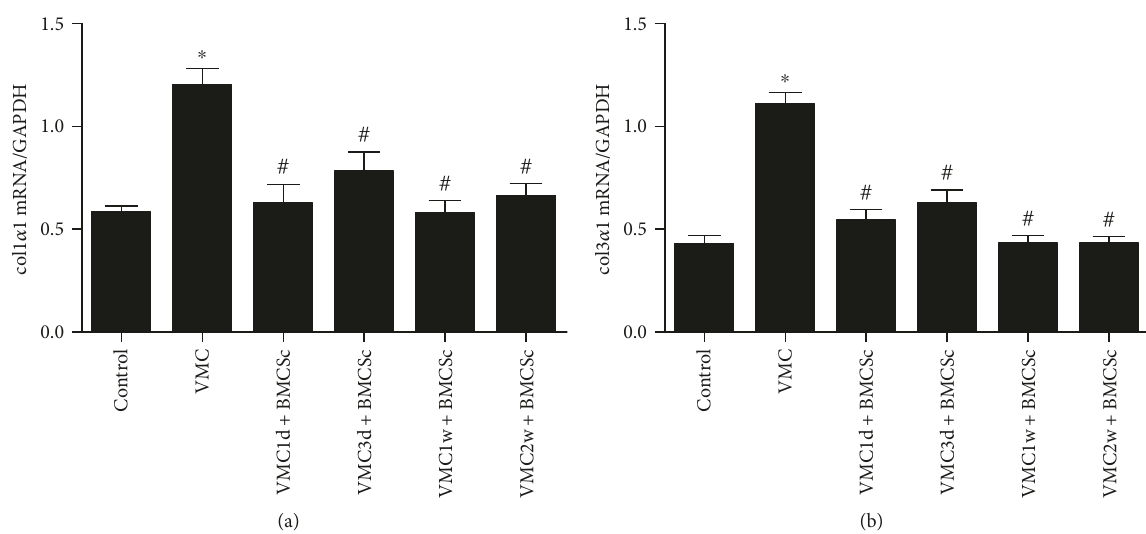
Figure 4: Quanti fi cation of col1 α 1 and col3 α 1 mRNA levels. (a) The relative expression of col1 α 1 mRNA in myocardial tissue. In 4 weeks after injection of CVB3, the expression of col1 α 1 mRNA was higher in the VMC group than in the BMSCs treatment subgroups. (b) The relative expression of col3 α 1 mRNA in myocardial tissue. The expression of col1 α 1 mRNA was higher in the VMC group than in the BMSCs treatment subgroups. n = 8 for each group. ∗ P < 0 05 when compared to the control group; # P < 0 05 when compared to the VMC group.